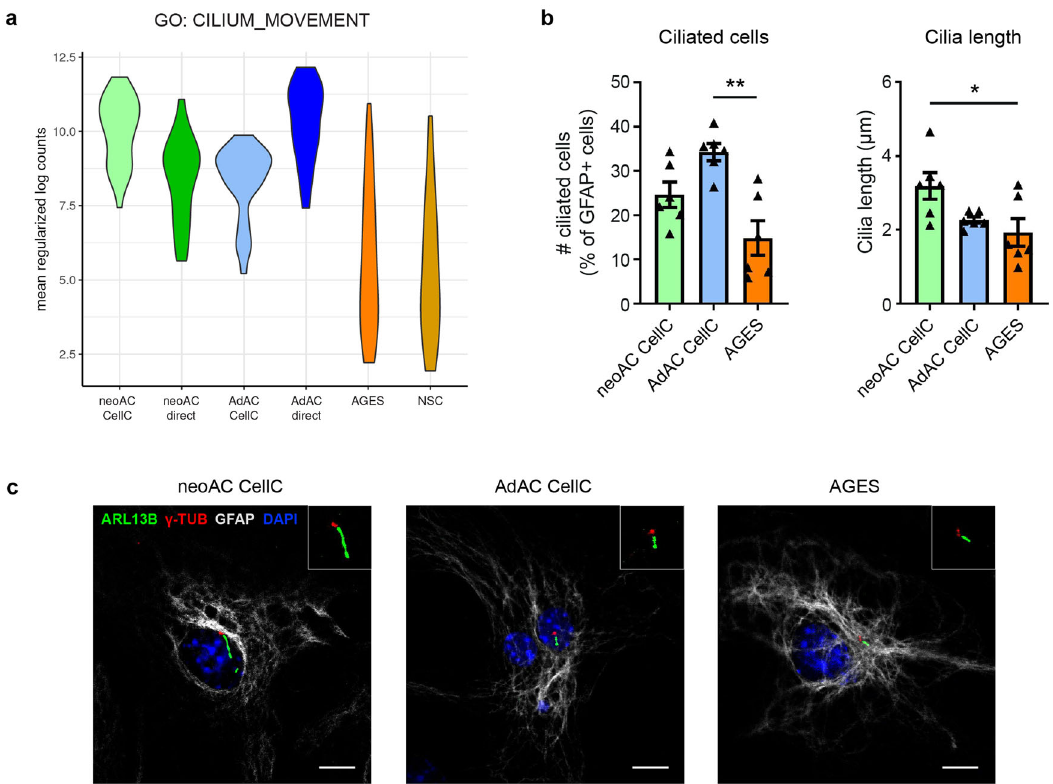
Fig. 4 Primary cilia morphology and appearance was affected by age and cell origin. a Comparison of the gene expression for 35 genes in the GO term cilium movement by displaying the mean regularized log counts. neoAC CellC vs. neoAC direct ** P = 0.0025; AdAC CellC vs. AdAC direct ***P < 0.001; neoAC CellC vs. AdAC CellC ** P = 0.0014; neoAC direct vs. AdAC direct ***P < 0.001; AGES vs. neoAC CellC ***P < 0.001; AGES vs. AdAC CellC ***P < 0.001; AGES vs. NSC non-signi fi cant. b , c Cultured neonatal (neoAC CellC) and adult (AdAC CellC) astrocytes and AGES were immunostained for the cilia marker ARL13B (green) and γ -TUBULIN (red) and counterstained with the astrocyte marker GFAP (white) and the cell nuclei marker DAPI (blue). The percentage of ciliated GFAP-positive cells compared to all GFAP-positive cells, as well as the cilia length in µ m, was determined by Fiji analysis. Representative images are shown in ( c ). Scale bar = 10 µ m. neoAC CellC ( n = 6), AdAC CellC ( n = 6), AGES ( n = 6); Mean± SEM, ANOVA with Tukey´s post hoc test; * P = 0.0264; ** P =